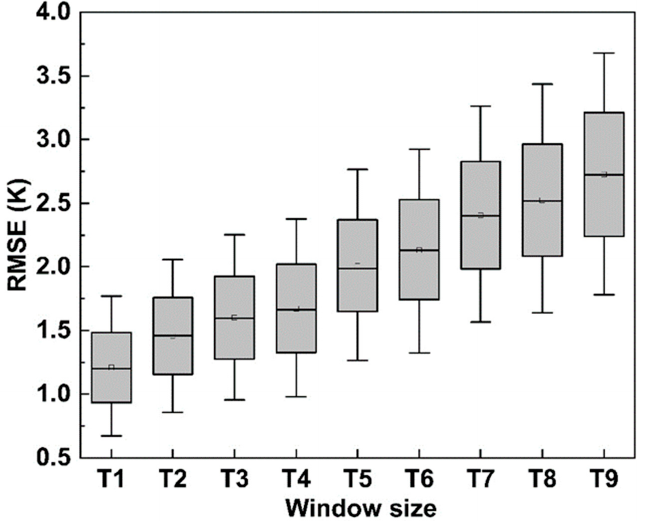
Figure A2. The accuracy variations of the ATC_GL depending on the increase in the size of the initial temporal window. T1–T8 denote the size of 1–9 days for the initial temporal window, respec ‐ tively.